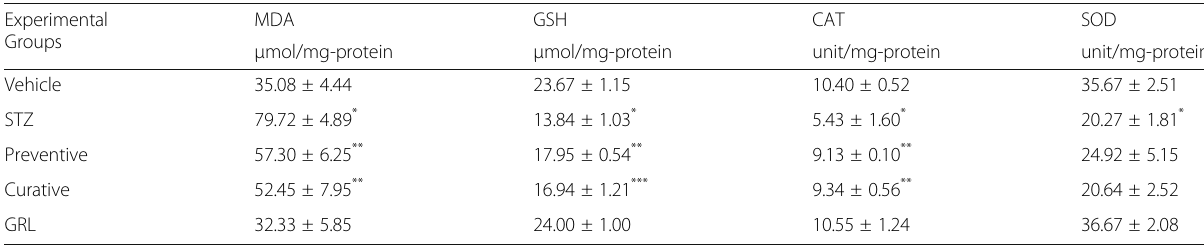
Table 3 Effect of the Juglans regia L. (GRL) leaf extract on biochemical markers of rat sciatic nerve affected by STZ-induced diabetic neuropathy